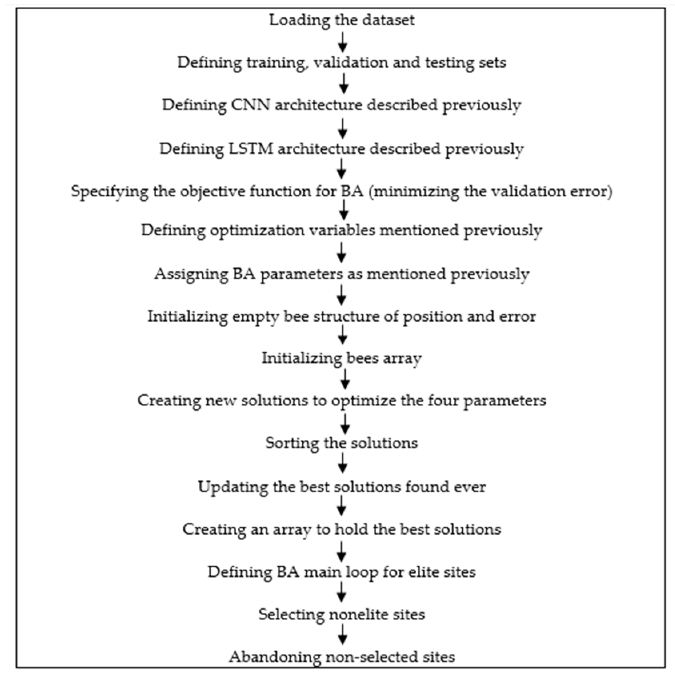
Figure 6. The pseudo-code for the proposed novel hybrid BA-CNN-LSTM algorithm.